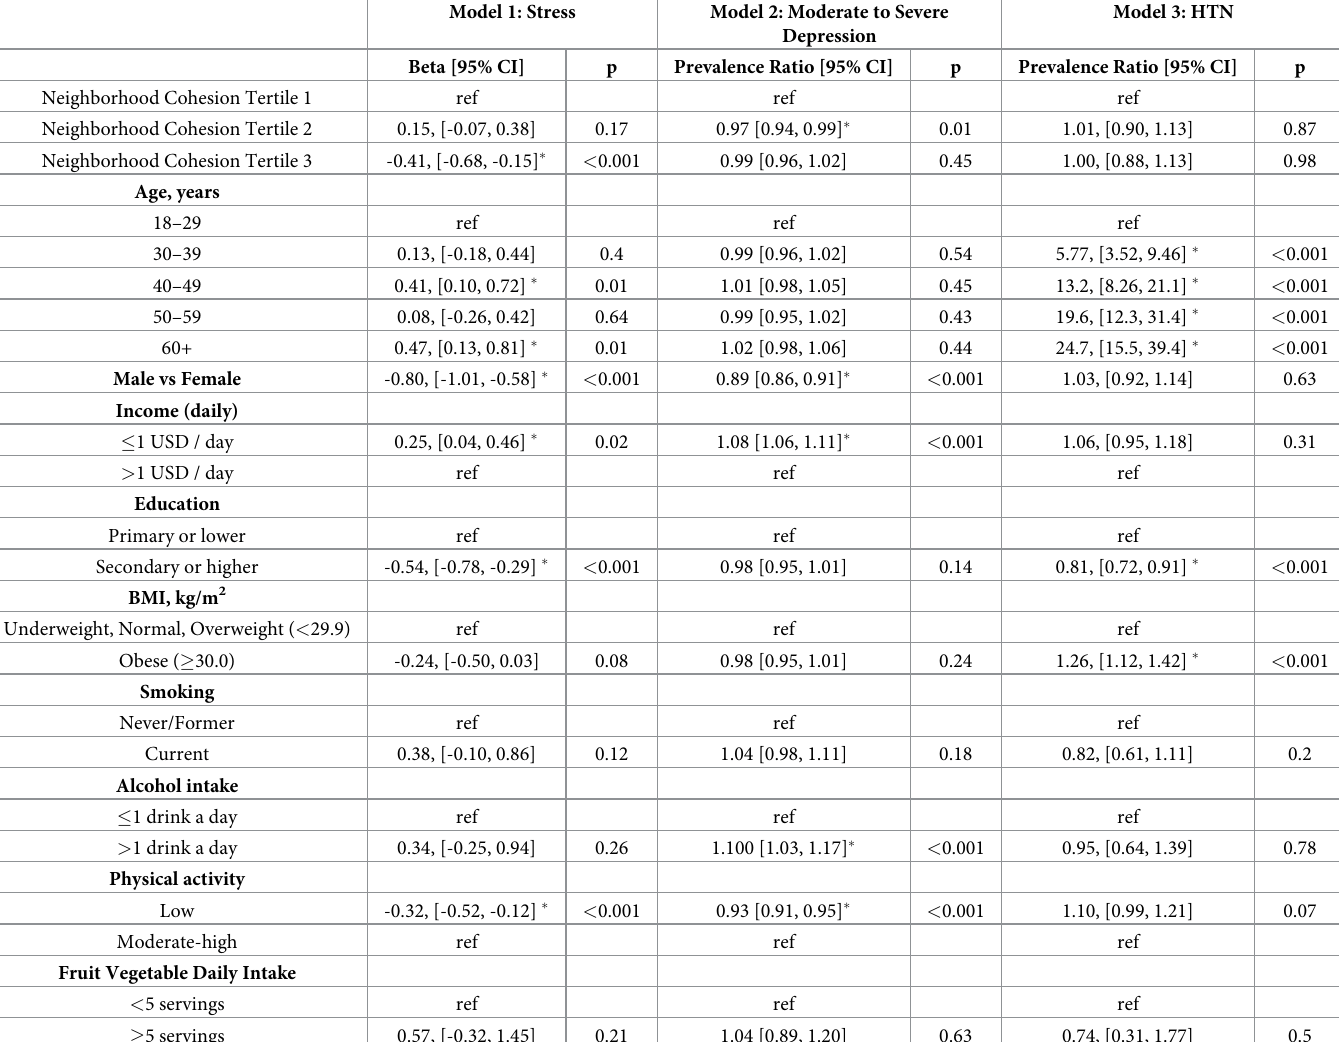
Table 3. Association between neighborhood cohesion and mental or physical health outcomes, multivariable linear regression and Poisson